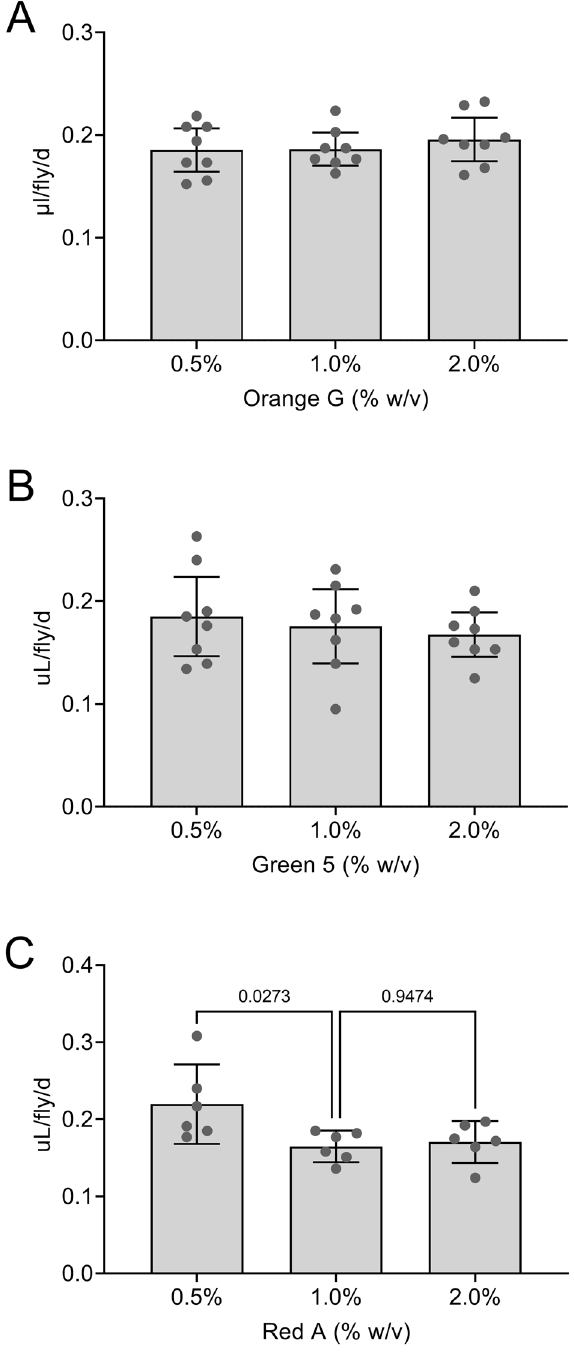
Figure 2. Effect of dye concentration on Con-Ex determined with Orange G, Green 5 and Red A in control females. GL females were allowed to consume-excrete 2Y10S3C media containing the indicated dyes at the concentrations shown for 24 h. ( A , B ) The concentration of Orange G ( A ) and Green 5 ( B ) did not significantly affect Con-Ex (individual one-way ANOVAs; Orange G, p = 0.4689; Green 5, p = 0.3937; n = 8). ( C ) The concentration of Red A significantly affected Con-Ex (one-way ANOVA, p = 0.0261, n = 6). Con-Ex determined using 0.5% and 1.0% Red A was significantly different (Bonferroni’s, p values shown for pair-wise